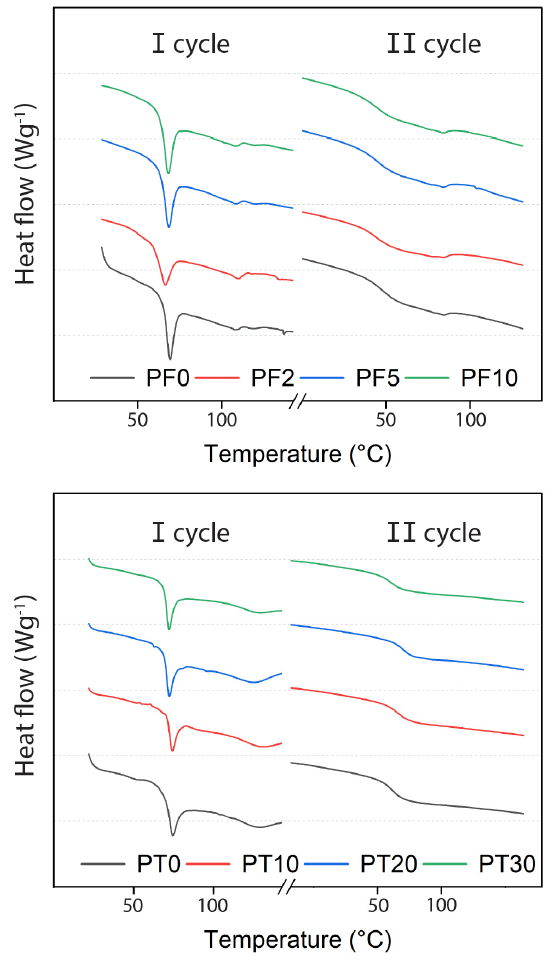
Figure 5. DSC data of samples PF ( upper ) and PT ( lower ).